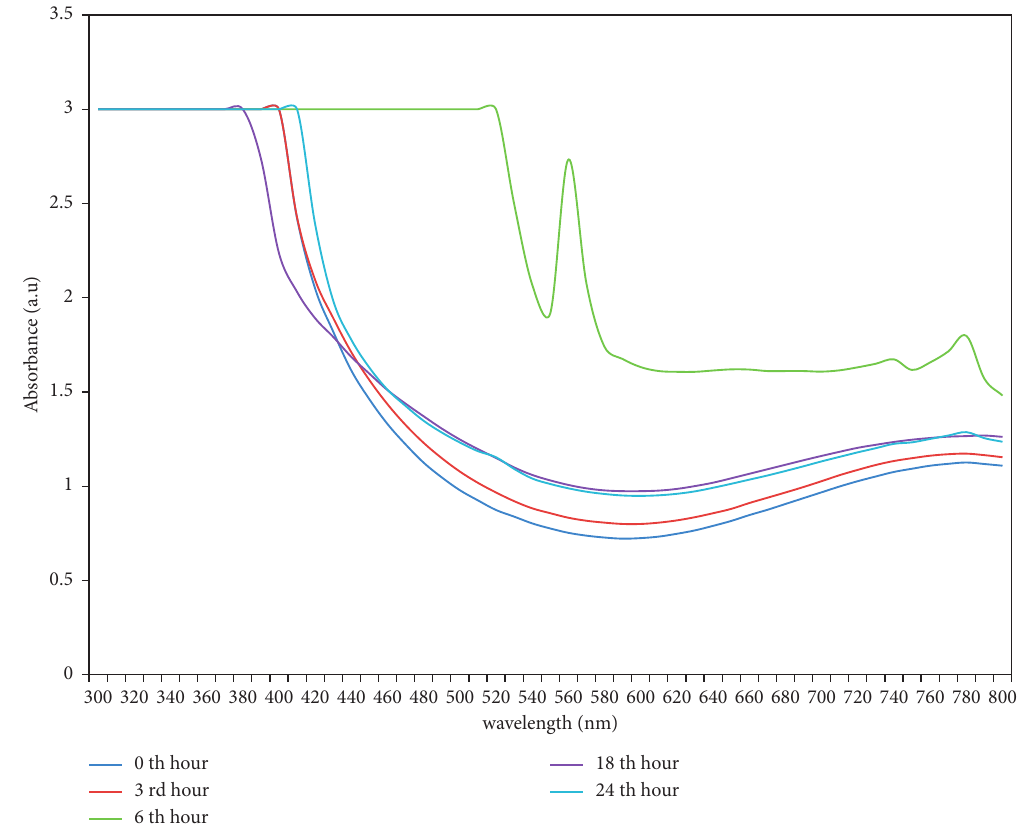
Figure 2: UV-Visible spectra of copper nanoparticles measured at wavelength ranges from 300nm to